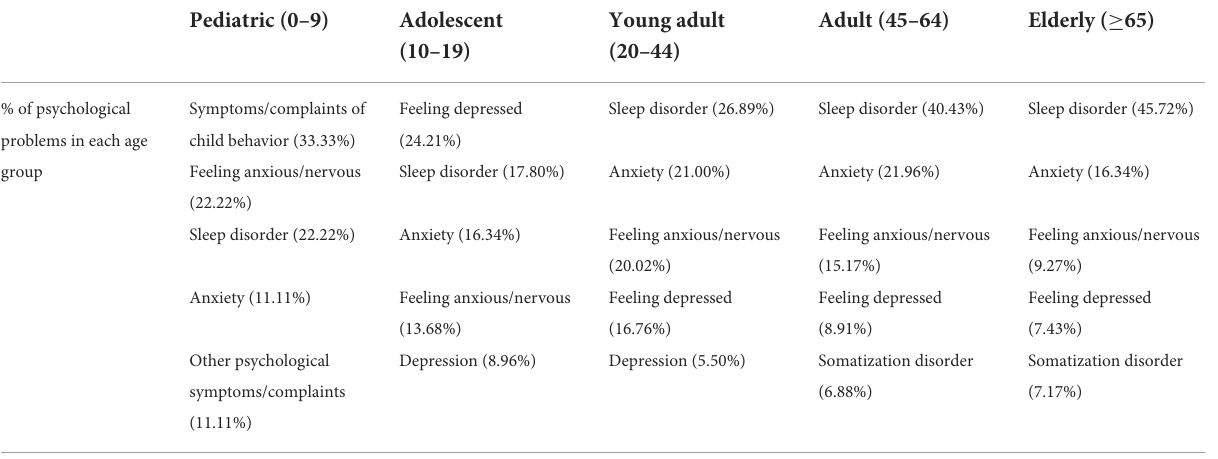
TABLE 6 Top five psychological problems in each age